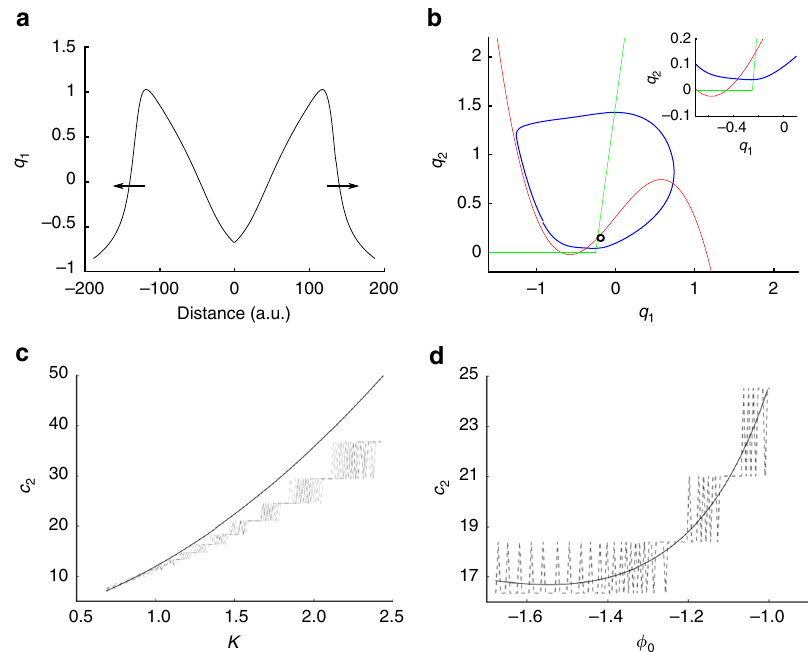
Fig. 4 Fast traveling spike-and-wave discharges in the Epileptor fi eld model. a Pulse solution for the second population (see also Methods). The spatial extension of the Epileptor fi eld model is shown larger than in previous fi gures for a better visualization of the pulse solution. b Phase space for the second population variables ( q 1 and q 2 ). The variable K , representing slowly evolving processes (e.g., extracellular potassium concentration) during the seizure, is high enough during the seizure so that the stable fi xed point of the system disappears by colliding with the other unstable fi xed point on the circle (saddle- node bifurcation on invariant circle), resulting in oscillatory activity (limit cycle) around the remaining unstable fi xed point. Red: nullcline for the variable q 1 ( _ q 1 ¼ 0). Green: nullcline for the variable q 2 ( _ q 2 ¼ 0). Blue: trajectory of the pulse solution. Black circle: unstable fi xed point. c Speed of SWDs ( c 2 ) in population 2 as a function of the variable K , i.e., for fi xed values of the permittivity variable and activity of the fast population. The speed of SWDs is two orders of magnitude higher than the slow ictal wavefront propagation and can vary substantially according to the values of variable K during the seizure. The black line indicates the prediction from the analytical solution based on a chain of uncoupled relaxation oscillators, while the different dashed lines indicate the speed obtained by direct numerical integration of the full Epileptor neural fi eld model, for different values of the coupling strengths ( γ 22 ). d Speed of SWDs ( c 2 ) in population 2 as a function of its initial phase ( ϕ 0 ) for K = 1.5. The speed of SWDs varies according to the instantaneous phase of the different oscillators. Same conventions as in